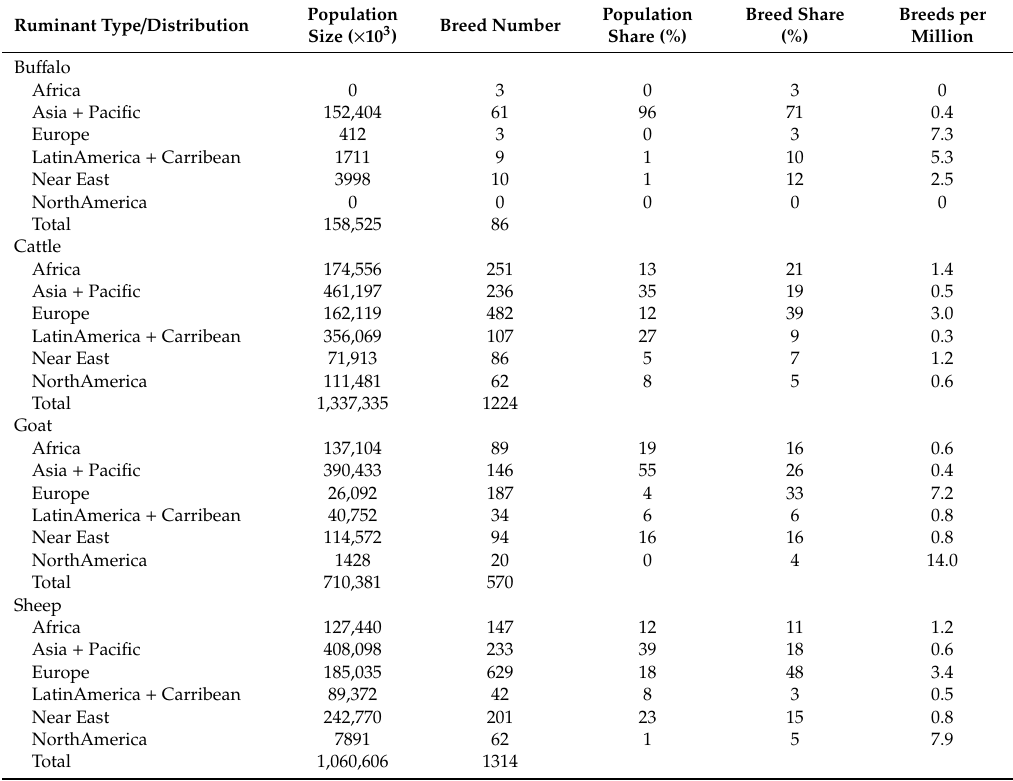
Table 1. Population size and distribution of bu ff alo, cattle, sheep and goat [31]. Ruminant Type /